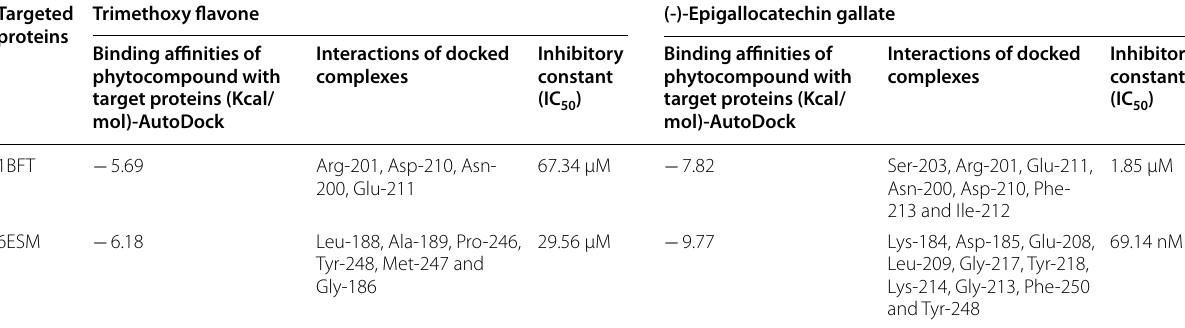
Table 1 Docking analysis of TMF and EGCG Targeted Trimethoxy flavone (-)-Epigallocatechin gallate proteins Binding affinities of Interactions of docked phytocompound with target proteins (Kcal/ mol)-AutoDock